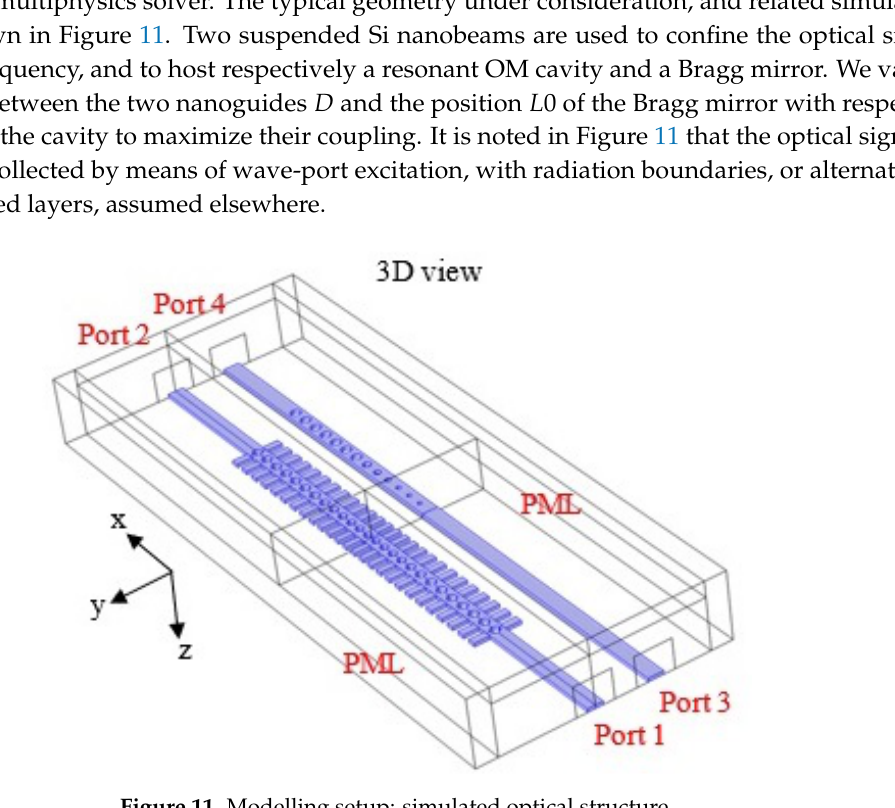
Figure 11. Modelling setup: simulated optical